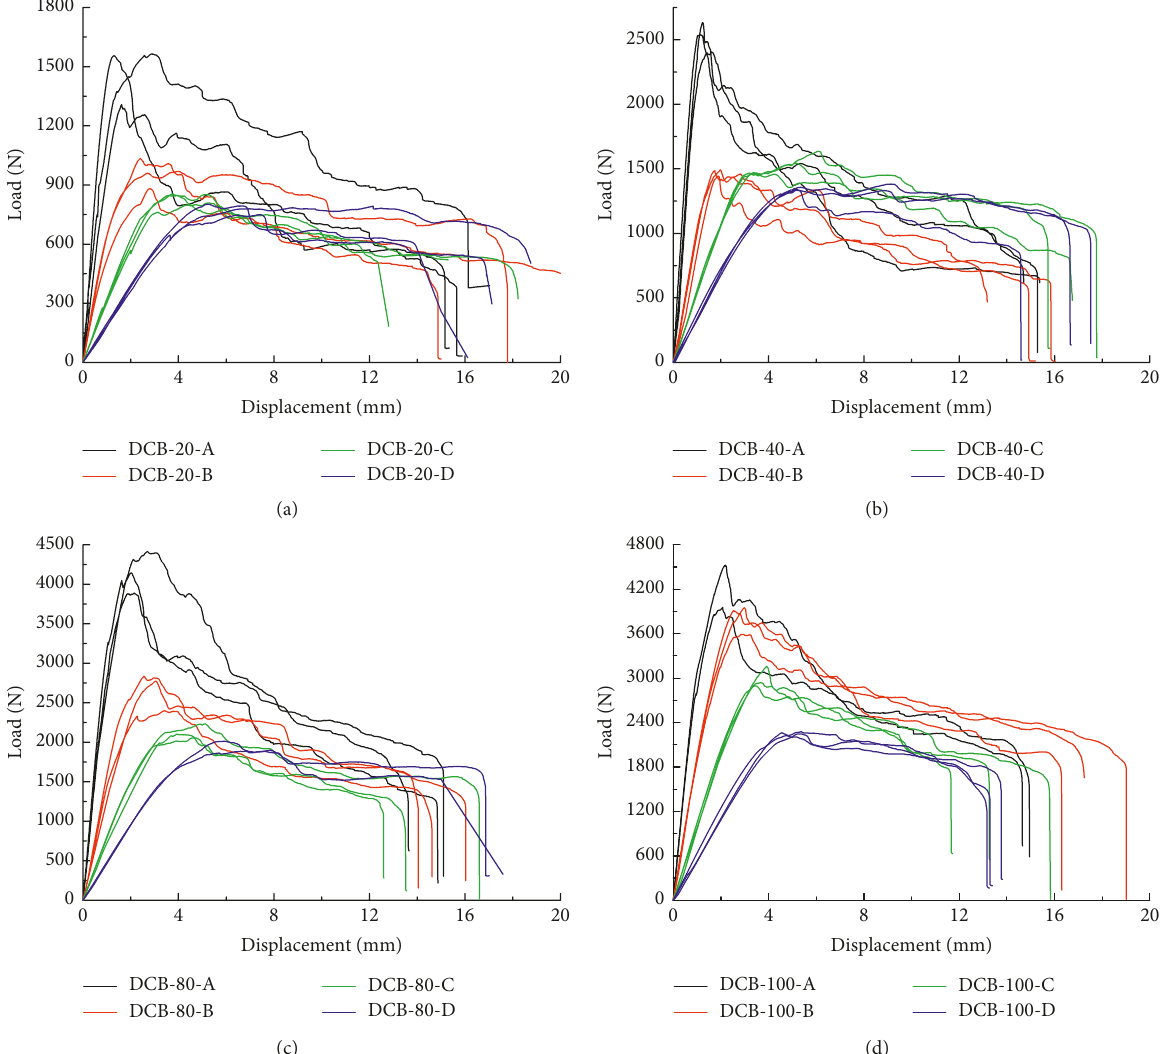
Figure 6: Load-displacement curves of all tested DCB specimens with different initial crack lengths in the same width: (a) width B � 20mm; (b) width B � 40mm; (c) width B � 80mm; and (d) width B � 100mm.